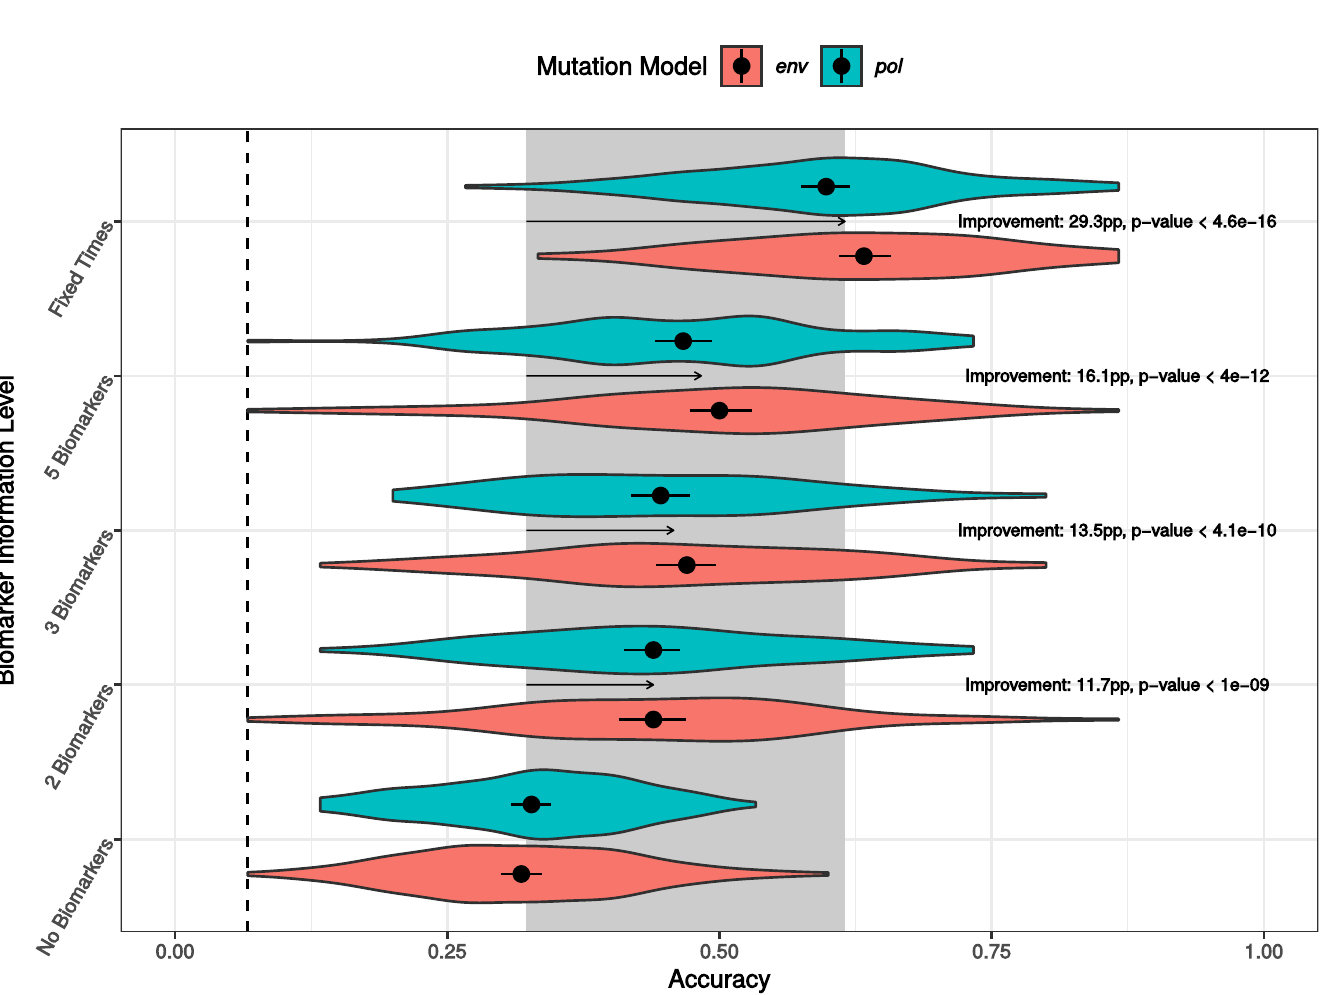
Fig 4. Transmission Inference Improvement with Biomarker Information. Violins show the full distribution of accuracy (proportion of the 15 individuals with the true infector correctly identified) on simulated data for each level of biomarker information and mutation model (genomic region), with the point and line segment in each violin representing the mean and 95% bootstrapped interval for the estimate of the mean. The vertical dashed line represents the random guess accuracy of 1/15. The gray shaded area in the background represents the region between the expected accuracy given effectively no information about infection times and given effectively fixed infection times, with the information level attainable with biomarkers falling between these two extremes. The improvement is shown with an arrow in percentage points (pp) and p value estimated by a Wilcoxon signed rank test with Bonferroni multiple testing